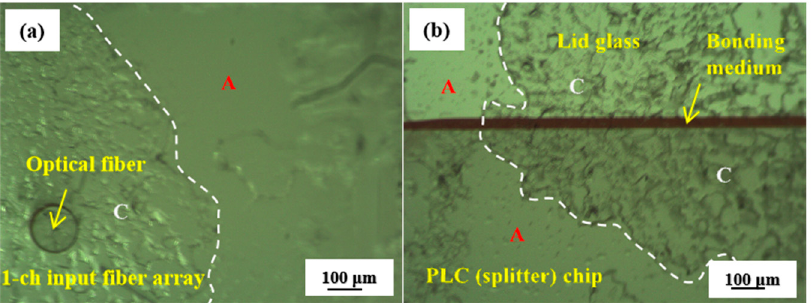
Figure 4. Typical optical micrograph of failure surfaces of a Type II fracture: ( a ) 1-channel fiber array end face; ( b ) PLC chip end face. (A = adhesive/interfacial failure, C = cohesive failure).